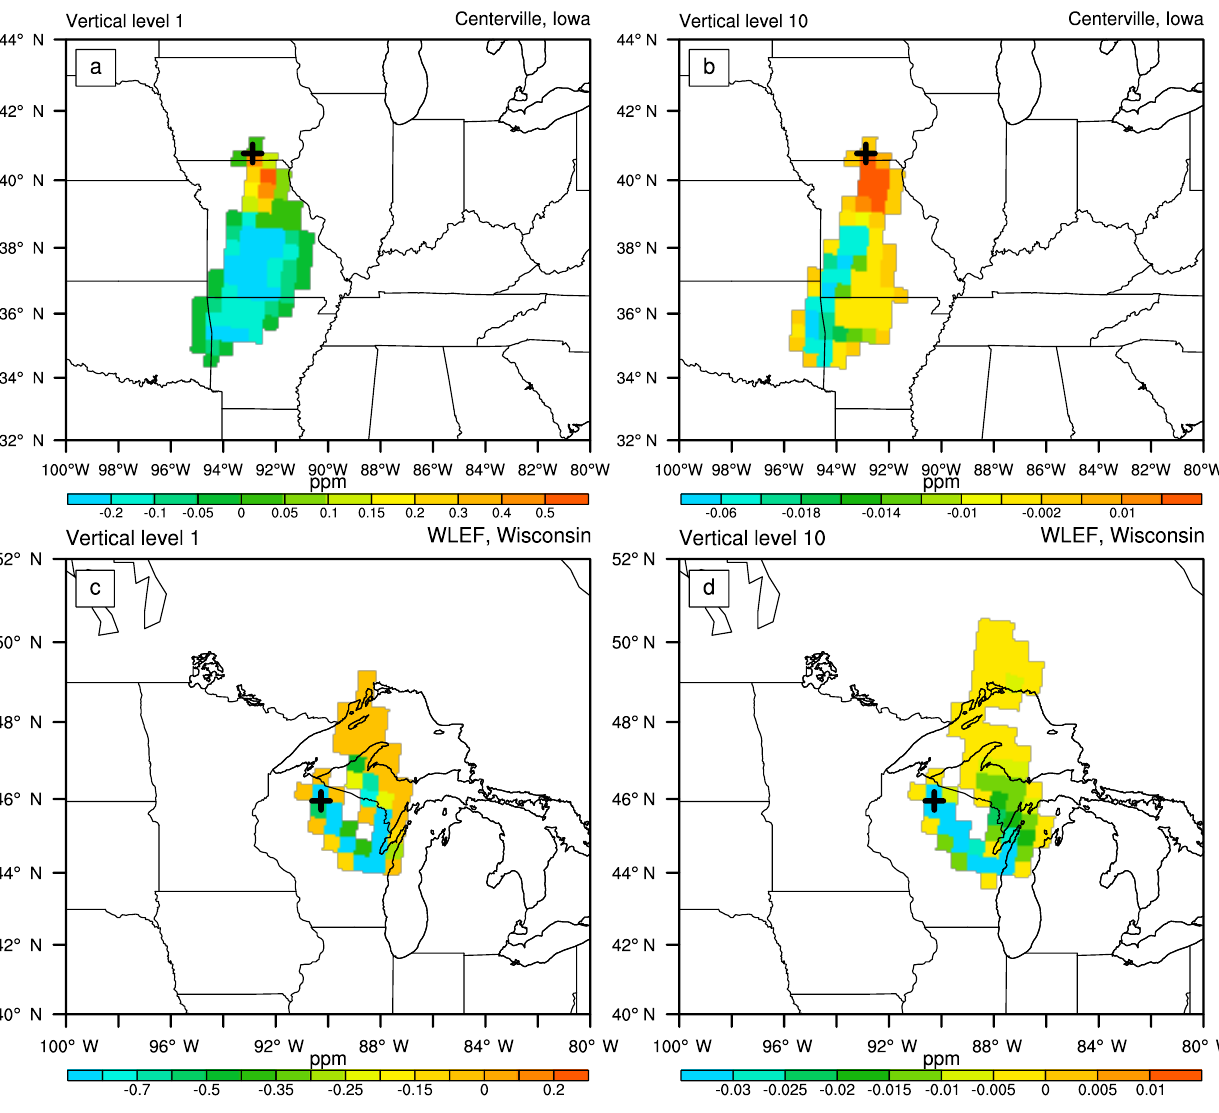
Figure 11. Footprints calculated using Hybrid Single-Particle Lagrangian Integrated Trajectory (HYSPLIT) backward trajectories and Car- bonTracker biospheric fluxes for the tower sites at Centerville, Iowa, and WLEF, Wisconsin. The receptor locations are the same as in Fig. 10. Each HYSPLIT footprint is plotted in the same color scale as its counterpart in Fig. 10 for